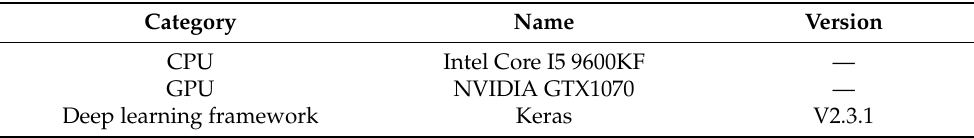
Table 4. Software and hardware